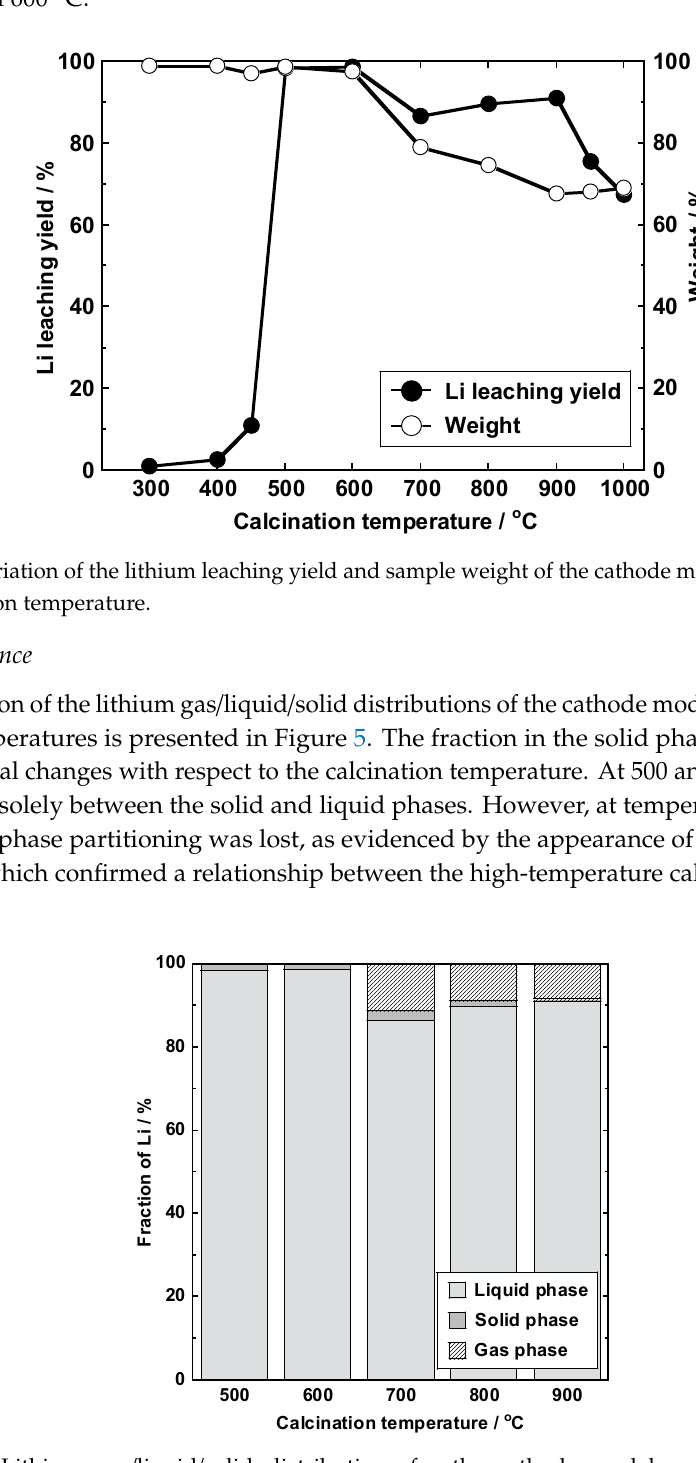
Figure 5. Lithium gas / liquid / solid distributions for the cathode model sample at di ff erent calcination temperatures.